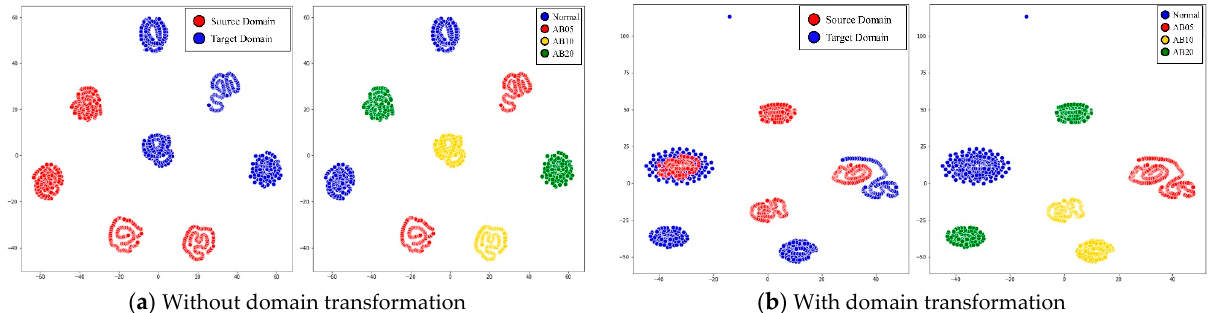
Figure 12. The t-SNE visualization of the feature at the latest hidden layer for each domain data, such as the source and target, and each class in CWRU.